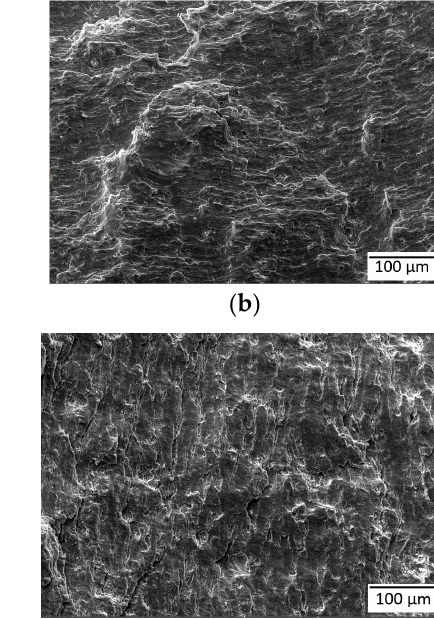
Figure 15. Optical micrographs of the fractured surfaces of the different LCF- and RF-tests, at 620 °C ( a ) LCF ± 0.2%, ( b ) RF ± 0.2%, ( c ) LCF ± 0.4%, and ( d ) RF ± 0,4%.